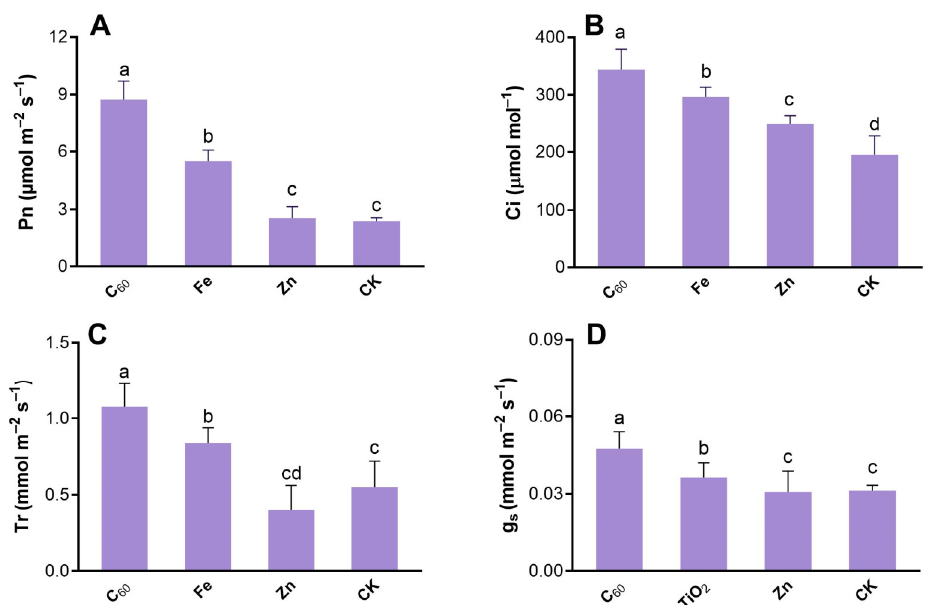
Figure 4. Carbon and metal-based MNOs significantly enhanced ( A ) net photosynthesis rate (Pn), ( B ) concentration of intercellular CO 2 (Ci), ( C ) transpiration rate (Tr), and ( D ) stomatal conductance (gs). Various letters represent the significance level across the applied treatments ( p < 0.05) (n = 3).